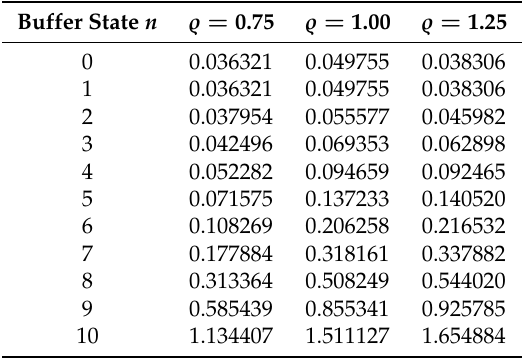
Table 2. Mean first buffer overflow duration in dependence on offered load and initial buffer